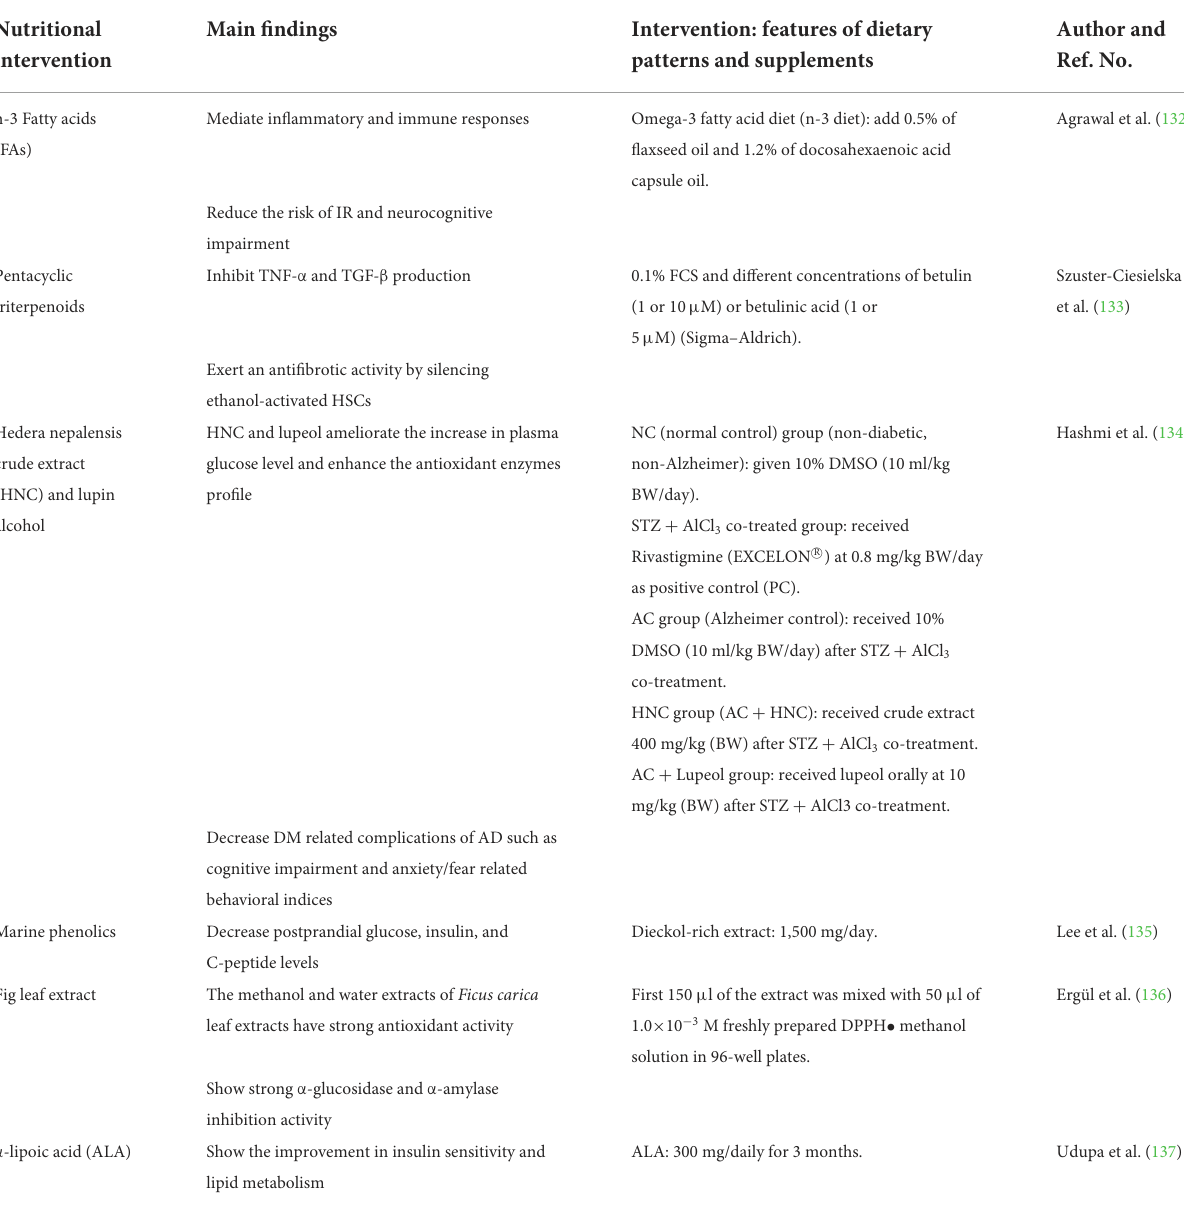
Fig leaf extract The methanol and water extracts of Ficus carica leaf extracts have strong antioxidant